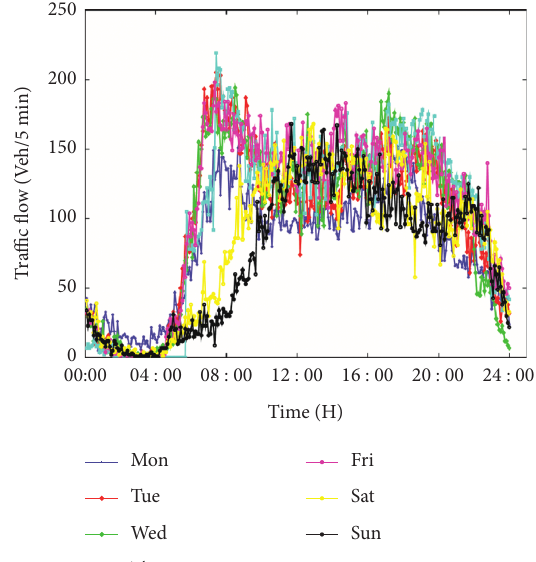
Figure 1: The traffic data of week model from Monday to Sunday.